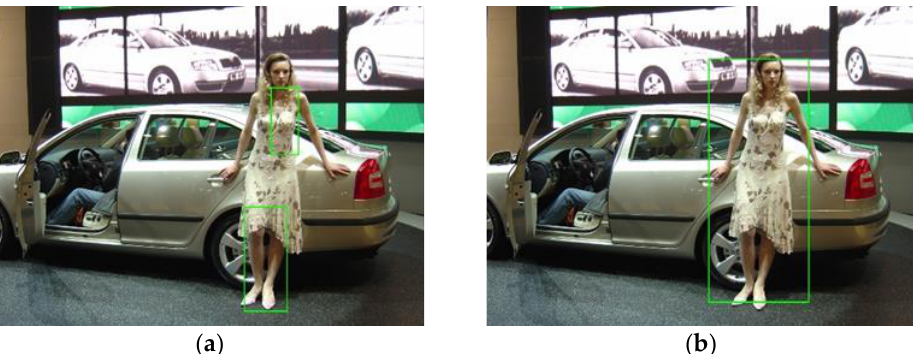
Figure 13. The human body is missed by the ACF detector ( a ), but it is detected by the integrated detector with 𝑓 𝑠𝑠 = 1 ( b ).